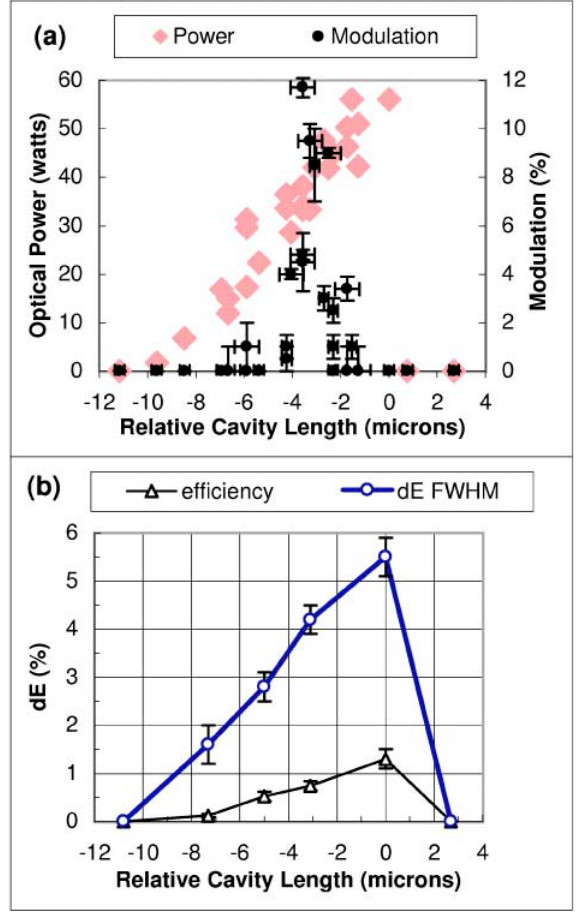
FIG. 7. (Color) (a) Measured microbunch modulation ampli- tude and FEL power as a function of optical cavity length. Since the absolute cavity desynchronism was difficult to de- termine during FEL operation, the relative cavity length was defined as zero at the smallest desynchronism (longest cavity length) where stable lasing occurred. Modulation percent is defined as one-half of the maximum peak-to-peak variation in electron beam density divided by the mean density over one wavelength. Power indicates the cw average of the intracav- ity optical power extracted from the 11.8 MHz pulsed elec- tron beam. The relative FEL power was monitored with a far-infrared detector, and an absolute calibration was estimated from the observed efficiency (defined below). (b) FEL-induced beam energy spread and efficiency as a function of optical cav- ity length. Efficiency is defined as the FEL-induced change in the mean electron energy divided by the initial mean electron